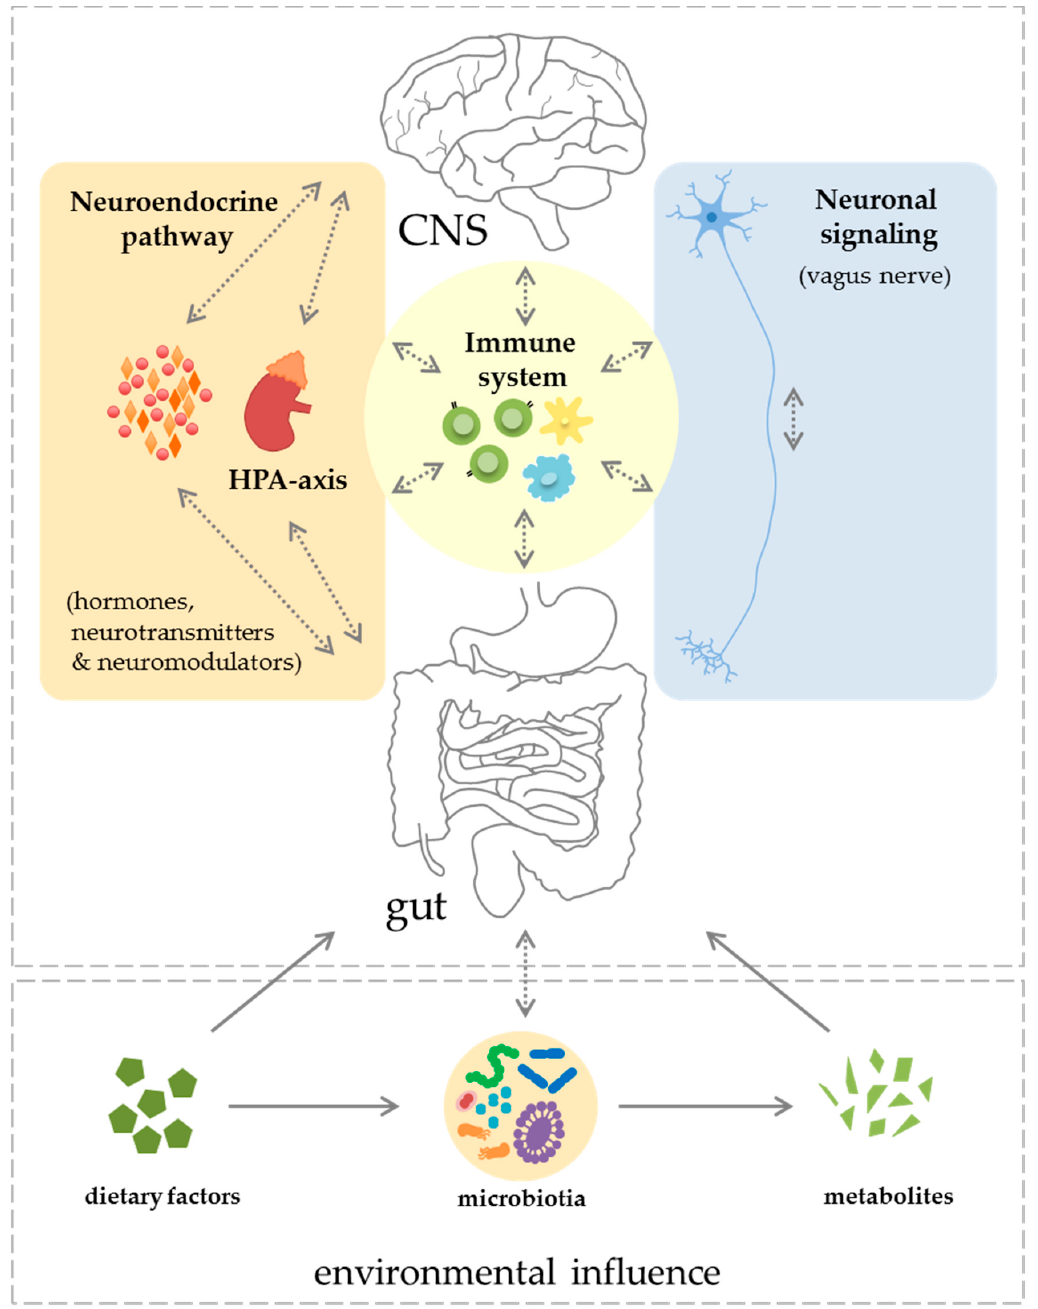
Figure 1. The gut–CNS-axis comprises several mutually interacting systems and signaling pathways. The main components are the neuroendocrine system including the HPA-axis, neuronal signaling via the vagus nerve and the immune system. CNS = central nervous system; HPA-axis = hypothalamic–pituitary–adrenal gland. ( ⟶ = unidirectional and < ⋯ > = bidirectional communication).